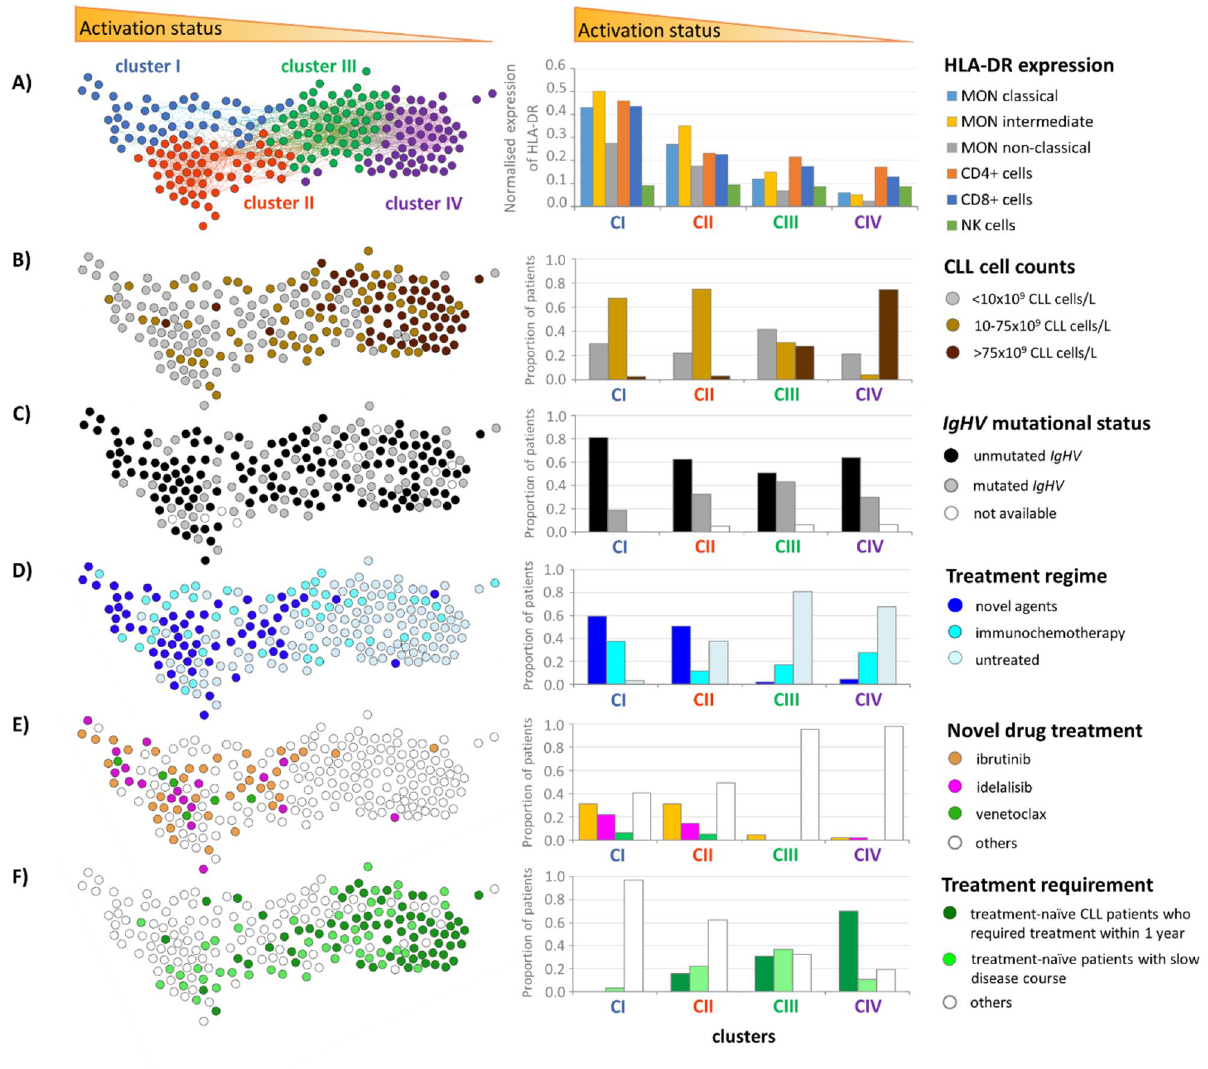
Figure 3. Patient Similarity Network (PSN) based on a combination of HLA-DR expression on monocyte subsets, CD4+ and CD8+ lymphocytes and NK cells and association of clinical parameters in particular clusters. The dots (= patients) were coloured based on the clinical data of each particular patient. Bar charts show the distribution of expression of the studied markers in individual clusters. ( A ) PSN consists of four clusters. Distribution of CLL patients and their proportion in particular clusters are visualised according to ( B ) CLL cell counts, ( C ) IgHV mutational status, ( D ) treatment regimen, ( E ) novel drug treatment, and ( F ) treatment requirement in treatment-naïve